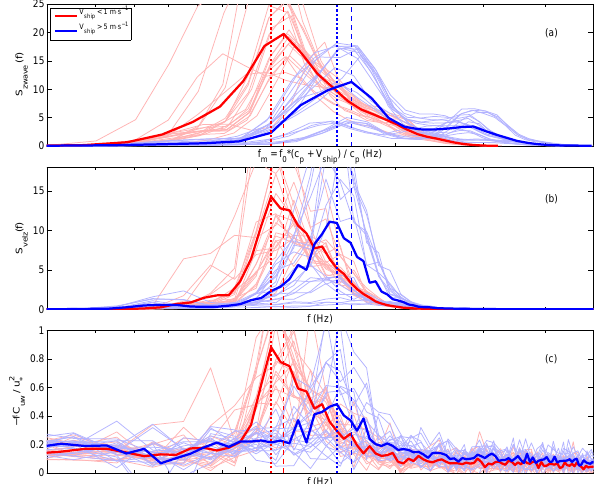
Figure 5. Comparison of averaged spectra. In all panels two sets of averaged data are compared: periods when the ship was station- ary ( V ship < 1ms − 1 , 21 periods) and periods when the ship was steaming ( V ship > 5ms − 1 , 20 periods); the individual spectra are shown as pale lines for reference. For all measurements, U 10n was between 10 and 12ms − 1 . (a) Spectral density of non-directional wave heights from WAVEX with frequency shifted to the reference frame of the moving ship; (b) spectral density of platform vertical velocity as measured on the foremast; (c) frequency-weighted in- verted cospectral density for the momentum flux (positive upwards) – turbulent velocity components are motion corrected, but the MSC correction is not applied. The dashed vertical lines indicate the peak frequency of the wave spectrum; dotted vertical lines indicate the peak frequency of the momentum flux cospectra in (c) . Note that the axis limits are set very close to the scale of the ship motion to allow details to be seen